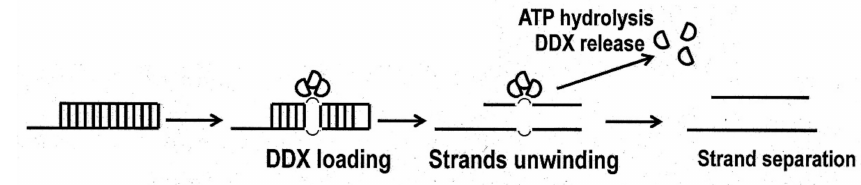
Figure 2. Local strand separation by DDX3 helicase